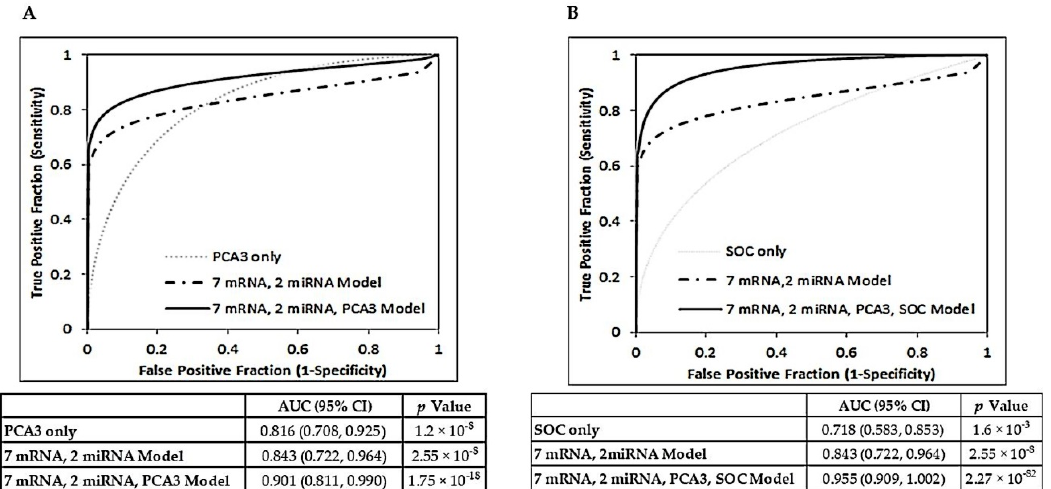
Figure 4. Multivariable models combining urinary Vn96-isolated EV 7 mRNA/2 miRNA panels with Vn96-isolated EV PCA3 values and clinical characteristics. ( A ) ROC curve analysis showing discrimination of Prostate Cancer (PrCa; n = 28) from Benign Control (BC; n = 28) using Vn96-isolated EV PCA3 values only, the seven mRNA/2 miRNA model only, and a multivariable model incorporating PCA3 with the sevn mRNA/2 miRNA values. ( B ) ROC curve analysis showing discrimination of Prostate Cancer (PrCa; n = 28) from Benign Control (BC; n = 28) using a model combining clinical characteristics observed as part of prostate cancer standard of care (SOC) only, the seven mRNA/2 miRNA model only, and a multivariable model including Vn96-isolated EV PCA3 results with seven mRNA/2 miRNA values and SOC characteristics. AUC, 95% CI and p values are provided below the plots.